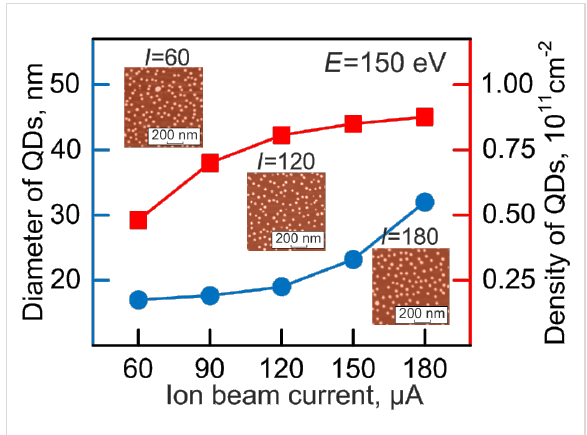
Figure 4: The dependence of average dimensions and surface densi- ty of InAs nanoislands on the ion current value.